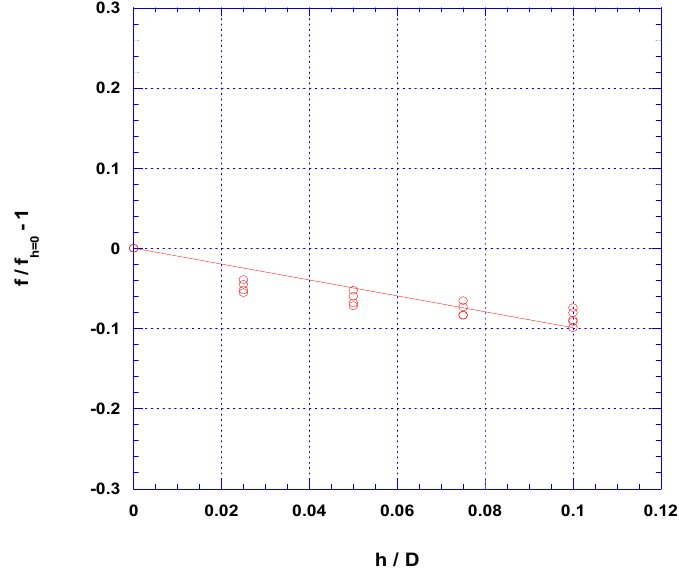
Figure A3. Variation of expression [( f / f o ) − 1] with dimensionless fouling-layer thickness.